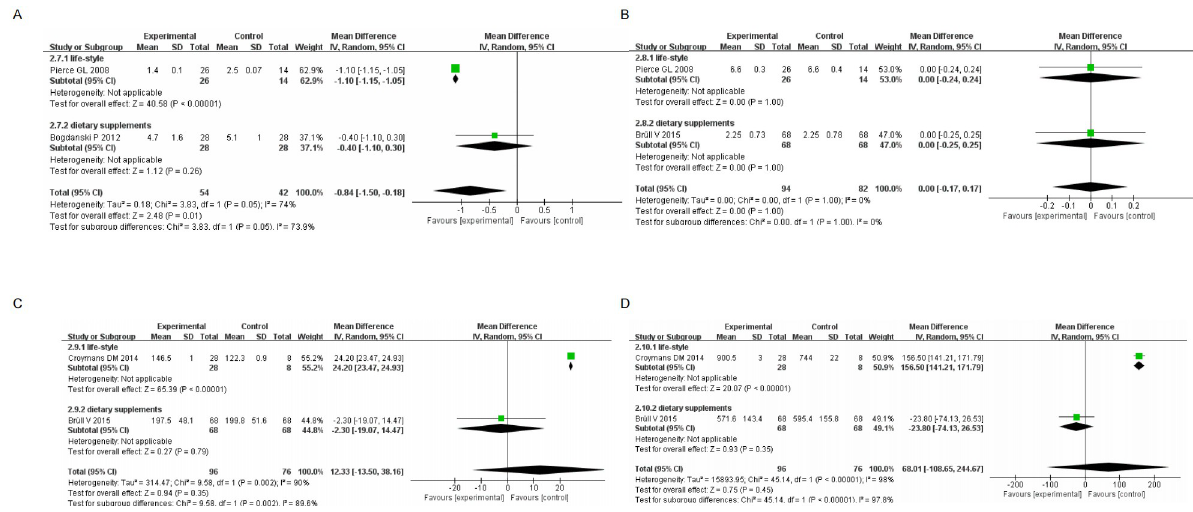
Fig 5. Forest plot of primary outcome indicators(III) (A) TNF- α Forest plot of primary outcome indicators (B) Endothelin-1 Forest plot of primary outcome indicators (C) sICAM-1 Forest plot of primary outcome indicators (D) sVCAM-1 Forest plot of primary outcome indicators.